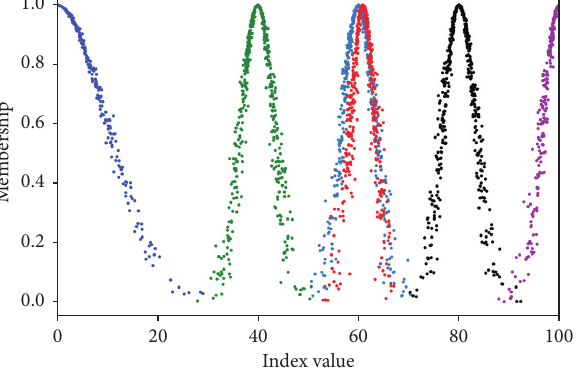
Figure 6: Cloud map of economic risk.